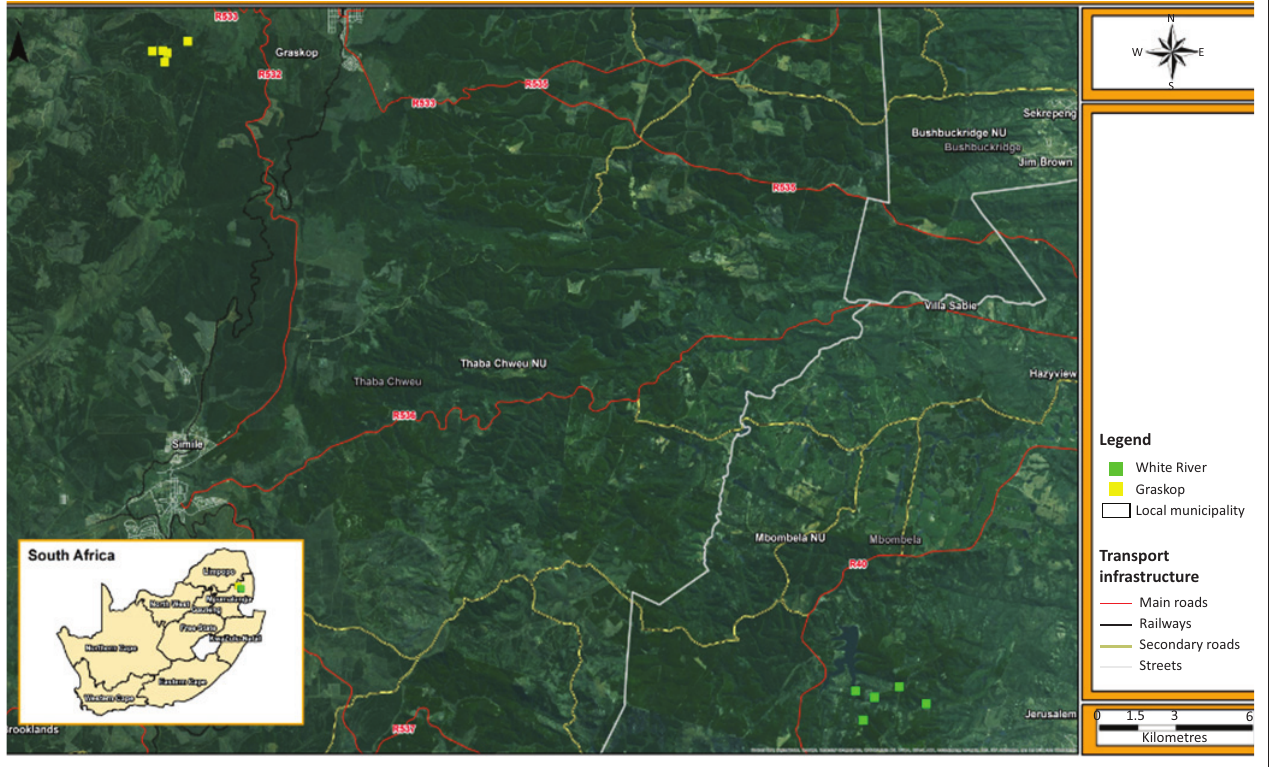
FIGURE 1: Site map showing sampling